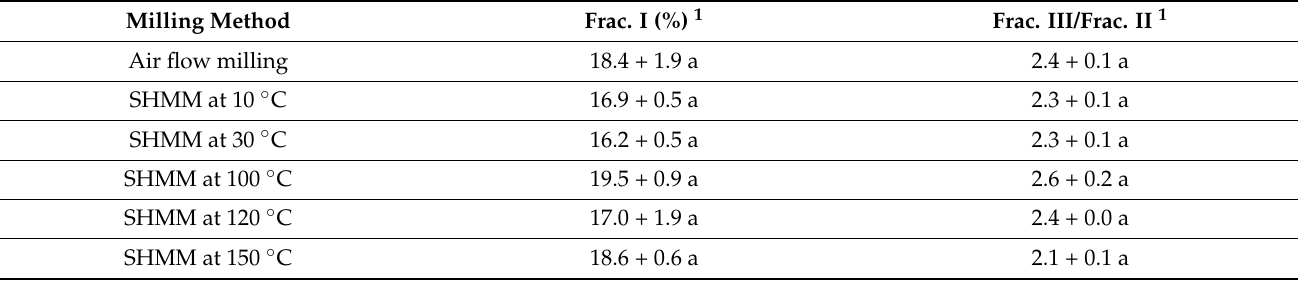
Table 2. Apparent Amylose Content and Ratio of Short-chain to Long-chain Molecules of Amy- lopectin in Various Rice Flour